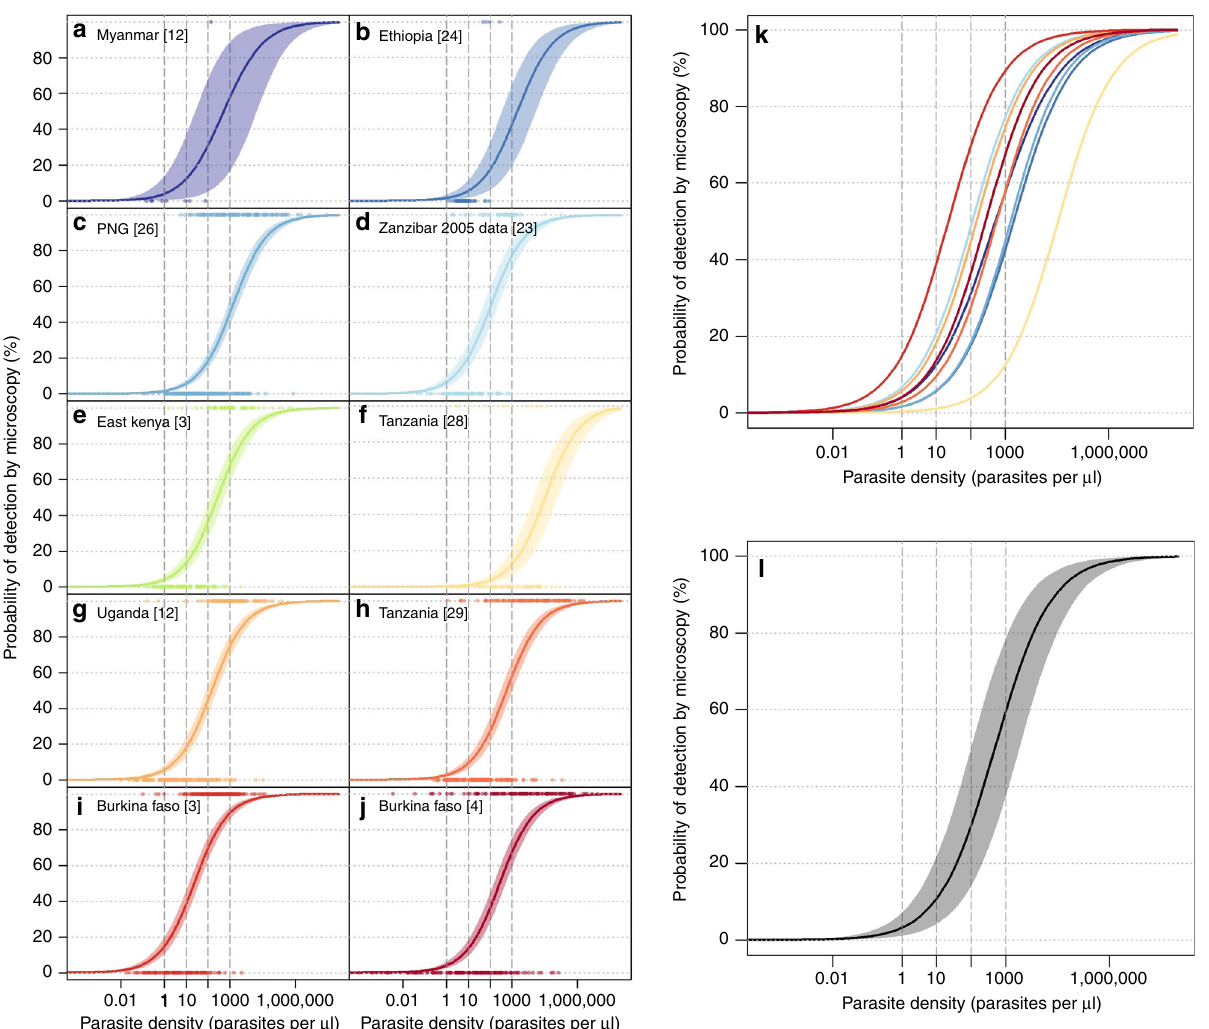
Fig. 2 Estimated probability of detection by microscopy based on qPCR parasite density. Logistic regression model fi ts for ten study sites ( a – j ) with associated Bayesian 95% credible intervals (shaded area). Median model predictions for each dataset are presented in panel k and a pooled prediction (without the study-level random effect) is presented in panel l . Source data are provided as a Source Data fi